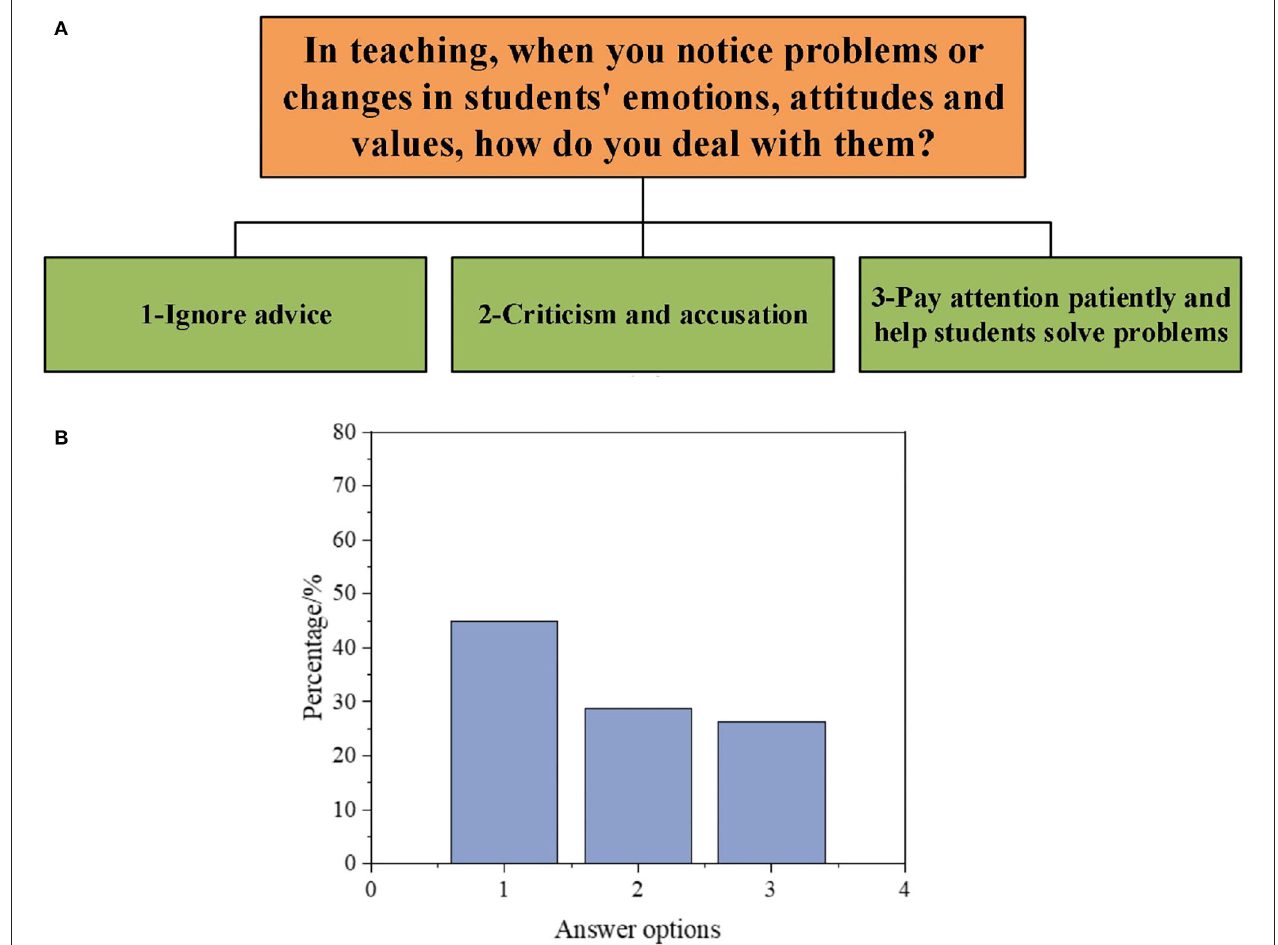
FIGURE 4 | Interview data on the DAU of students’ psychological experience-oriented GCR [ (A) : questions and options; (B) : proportion of options].